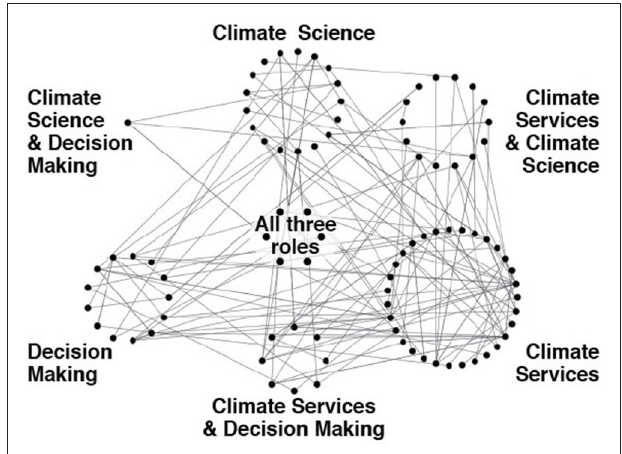
FIGURE 3 | Network ties across the climate science-practice interface in